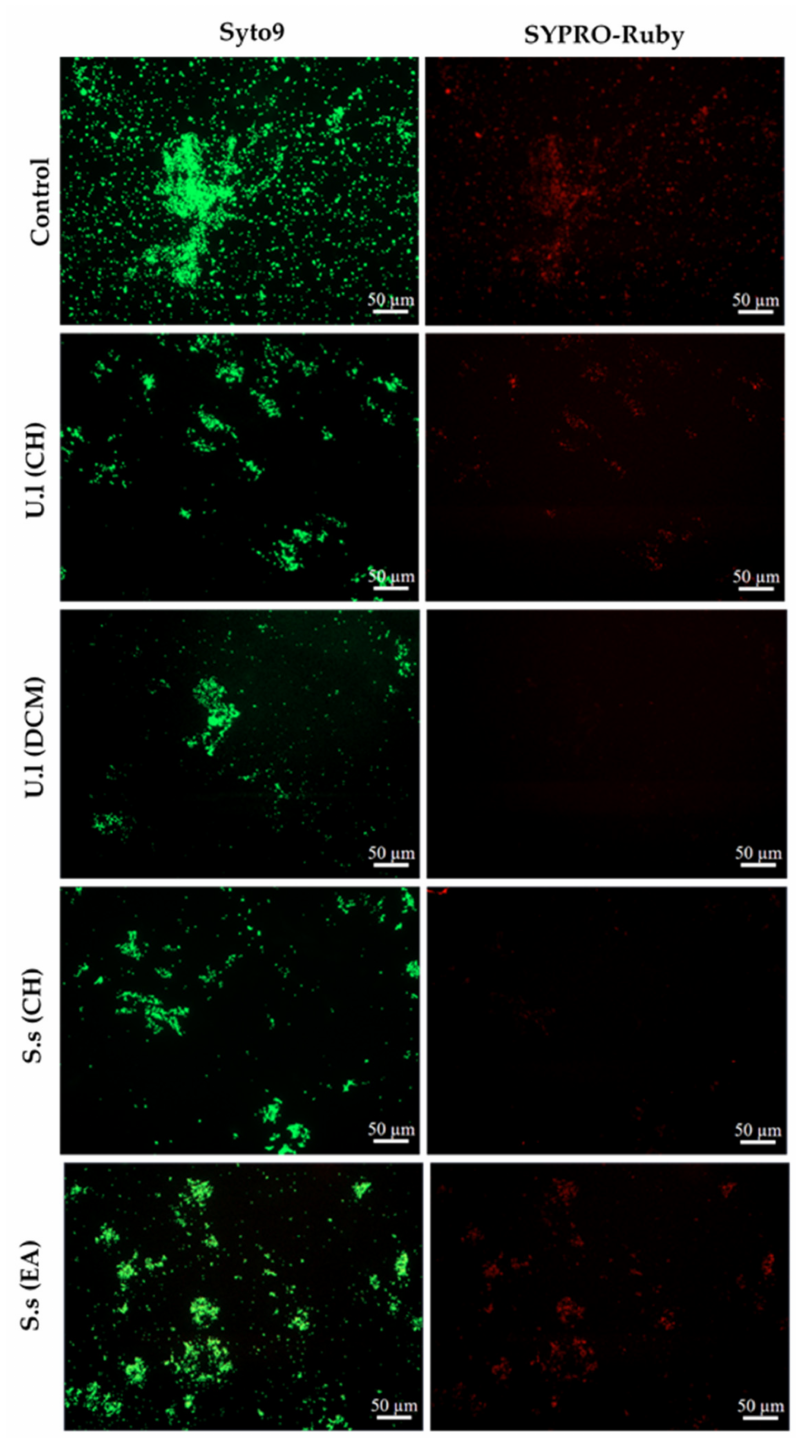
Figure 2. Epifluorescence microscopy images of S. aureus biofilms incubated in BB medium at 37 ◦ C for 24 h without extract (control) or with selected extracts (CH and DCM extracts of U. lactuca and CH and EA extracts derived from S. scoparium ) at 50.0 µ g/mL. Biofilms were stained with Syto9 for cells visualization (green-fluorescent) and with SYPRO-Ruby for the visualization of matrix proteins (red-fluorescent). U.l and S.s are U. lactuca and S. scoparium algae, respectively. (Magnification ×